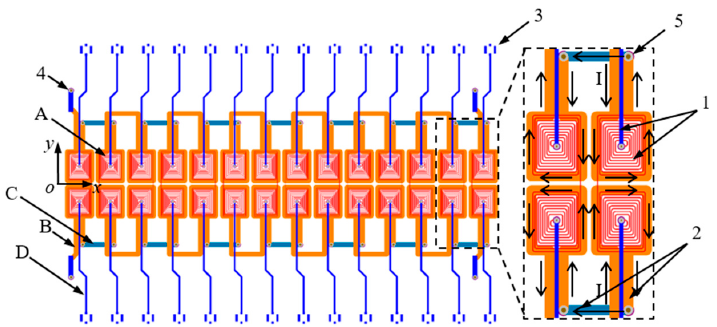
Figure 2. Schematic diagram of the sensor. A—Top layer; B—Mid-layer 1; C—Mid-layer 2; D—Bottom layer; 1—Sensing traces; 2—Excitation traces; 3—Terminals of sensing traces; 4—Terminals of excitation traces; 5—via hole.